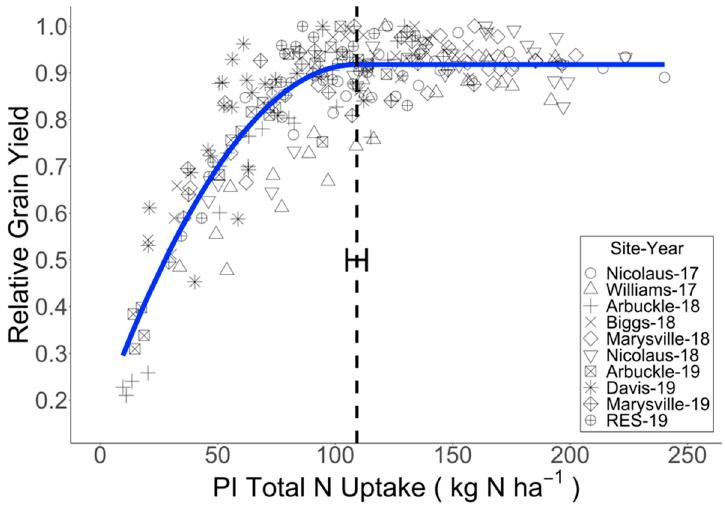
Figure 3. The relationship between total N uptake at panicle initiation rice growth stage (PI-N UP ) and relative grain yield as described by a quadratic-plateau linear regression model. The vertical dashed line at 109 kg N ha − 1 represents the PI-N UP value where the relationship reaches a plateau, and the error bar around the line represents the standard error.